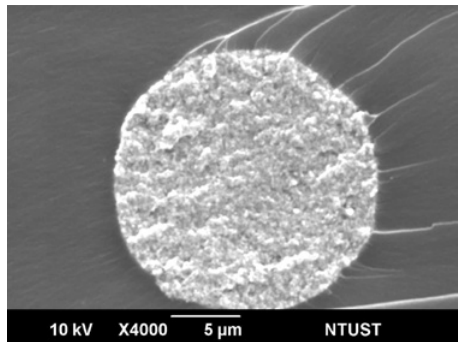
Figure 3: The extreme agglomeration tendency of nano BaTiO observed on SEM image from tensile sample with 5 phr filler loading. Figure 4: Hardness as a function of filler